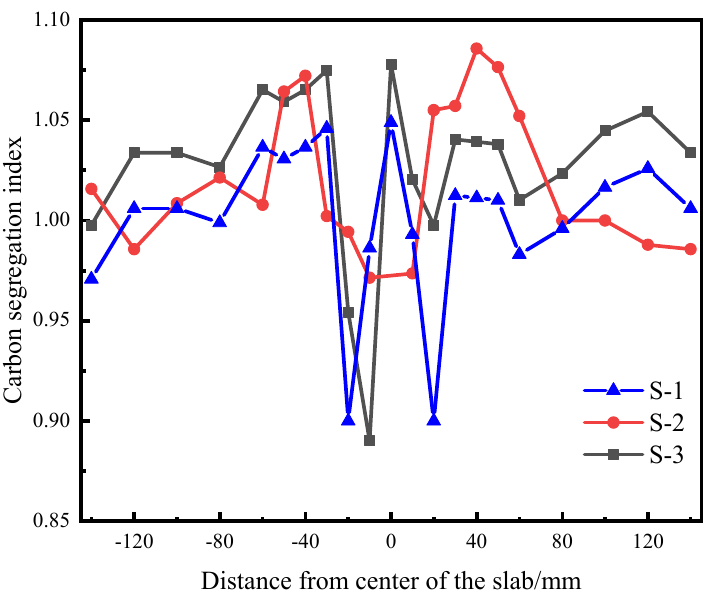
Figure 18. Comparison of carbon segregation index between the S − 1, S − 2, and S − 3 slab.